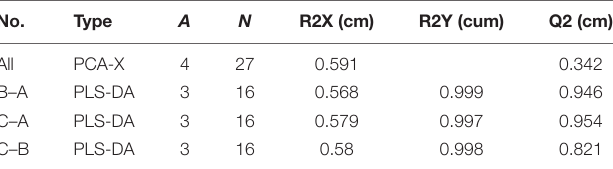
TABLE 3 | Each parameter of PCA model.